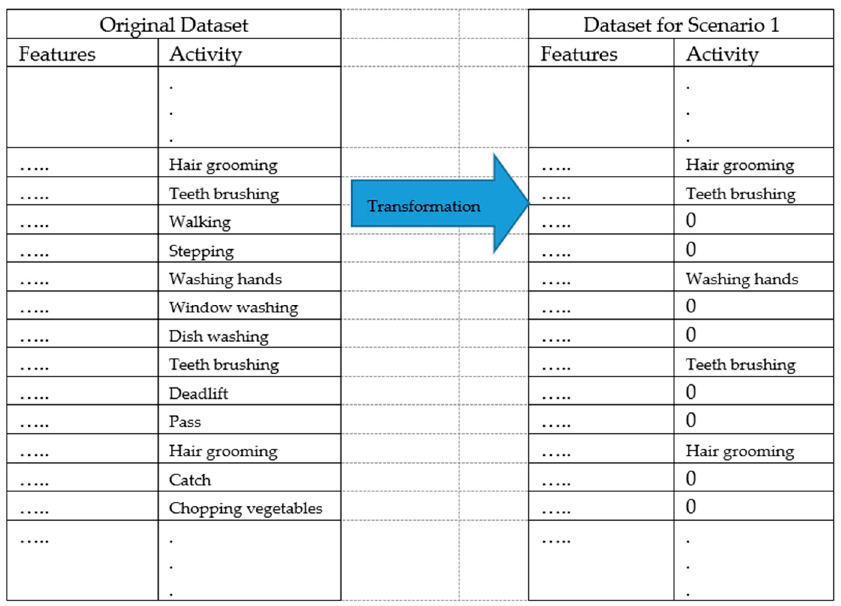
Figure 2. Transformation of the original dataset for the dataset of Scenario